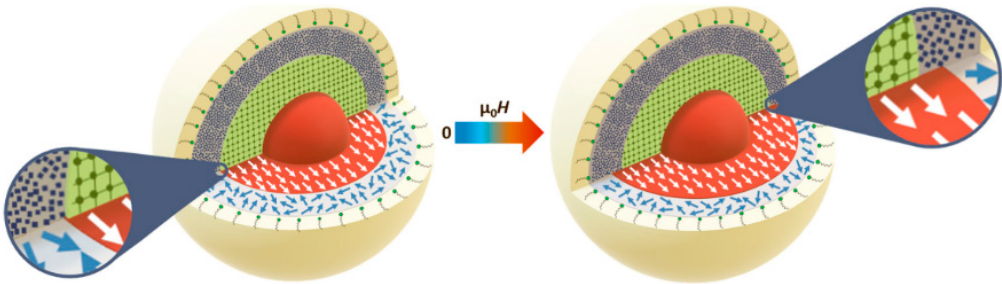
Figure 17. Schematic of the structural and field-dependent magnetic NP morphology: The vertical cuts represent the structural morphology, consisting of a structurally coherent grain size (green) and structural disorder (blue) within the inorganic particle (gray). The horizontal cuts represent the magnetic morphology, consisting of a collinear magnetic core (red) and spin disorder (blue) within the inorganic particle surface layer (gray). The particle is surrounded by an oleic acid ligand layer (beige). Structural and magnetic particle sizes are equal in zero field (left), whereas the initially disordered surface spins are gradually polarized in the applied magnetic field such that the magnetic radius increases beyond the structurally disordered surface region (right) (Reprinted from [240] under CC—Creative Commons Attribution 4.0 International license.).